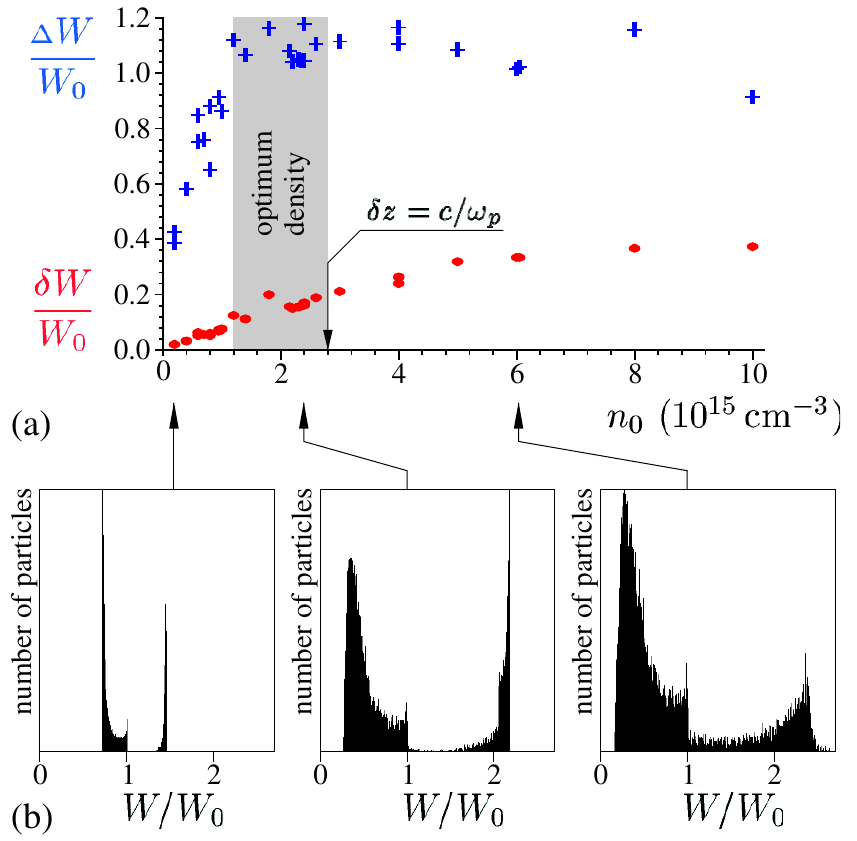
FIG. 4. (Color) (a) Dependence of the witness energy gain (cid:1) W (crosses) and energy spread (cid:3)W (ovals) on the plasma density; (b) typical energy spectra at various densities.